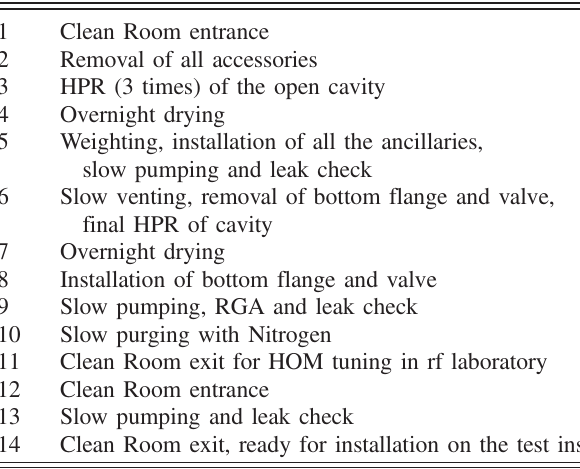
TABLE VII. Cavity preparation steps for rf test.